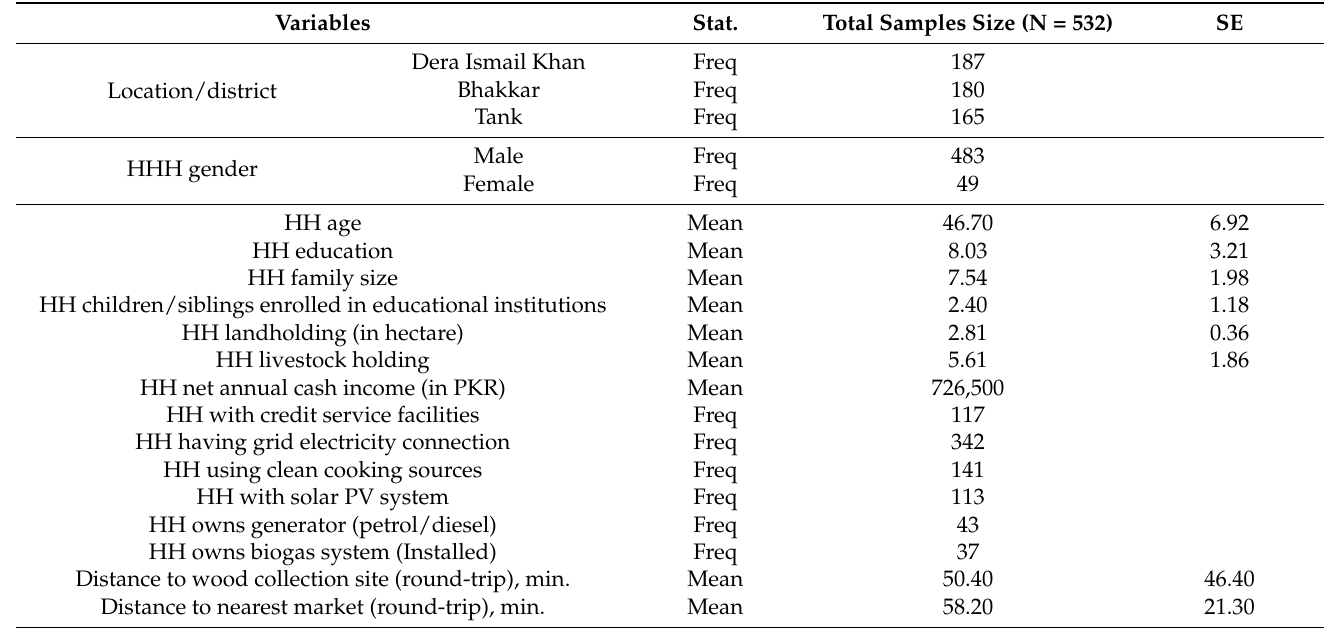
Table 2. Descriptive statistics of the households’